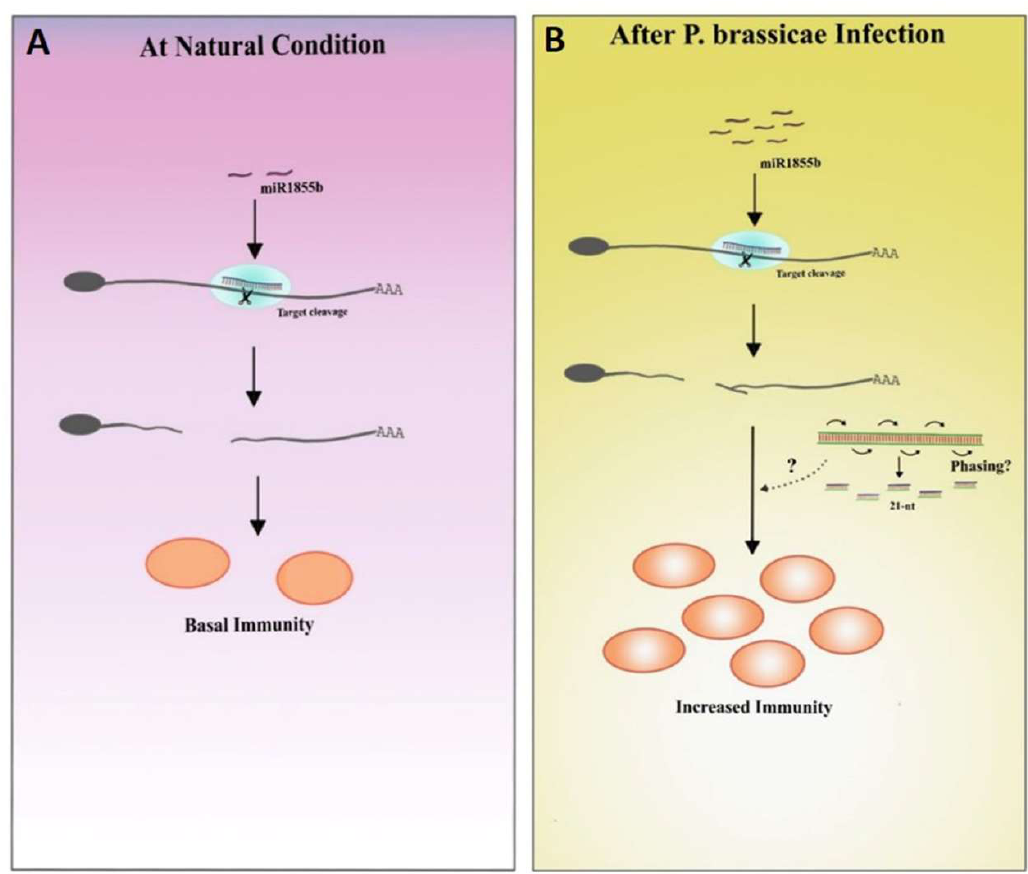
Figure 8. Proposed hypothesis based on the results of this study. ( A ) Under natural conditions, miR1885b is expressed at low levels, which is conducive to basal immunity. ( B ) During pathogen infections, miR1885b levels increase, which may enhance immunity through phasiRNAs.